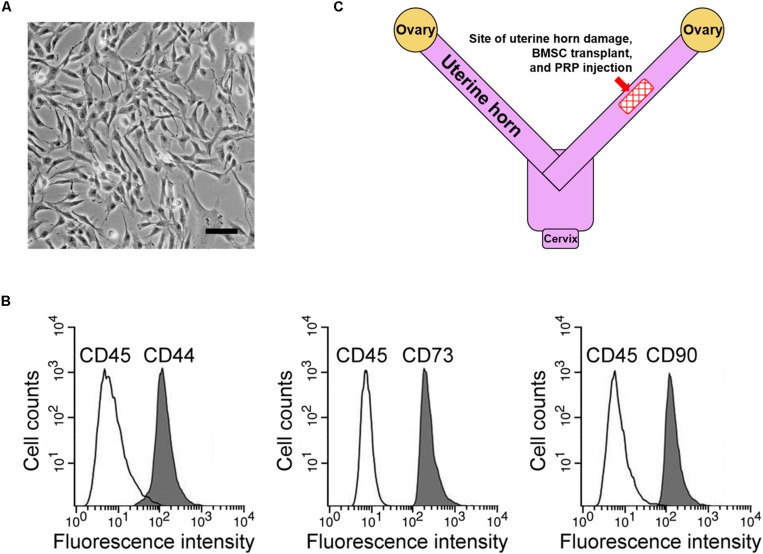
BMSC isolation and rat uterine horn damage model. (A) Representative image of cultured BMSCs, scale bar 100 μm. (B) Flow cytometry identified BMSC positive surface markers CD44, CD73, and CD90, and negative surface marker CD45. (C) Illustration of the rat model, showing the site for uterine horn damage, BMSC transplant, and PRP therapy.